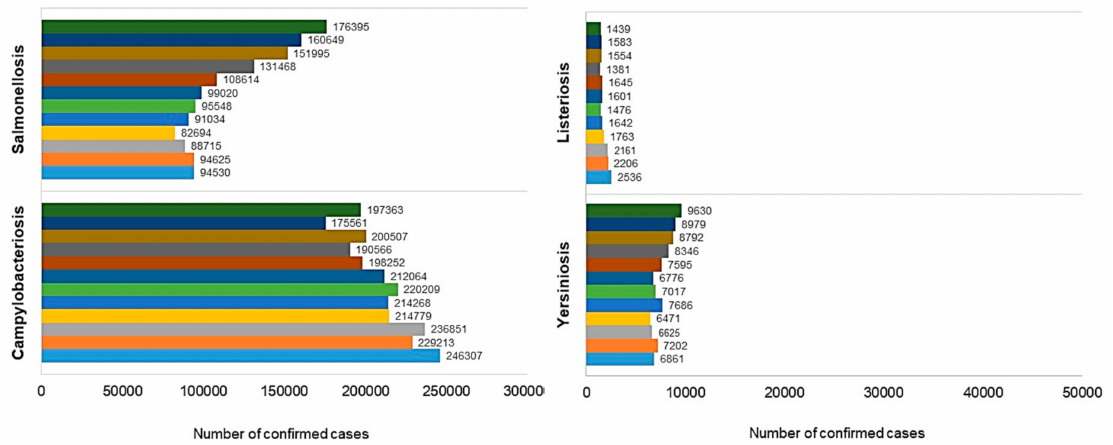
Figure 2. Number of confirmed cases of selected bacterial zoonoses in the European Union between 2005–2016